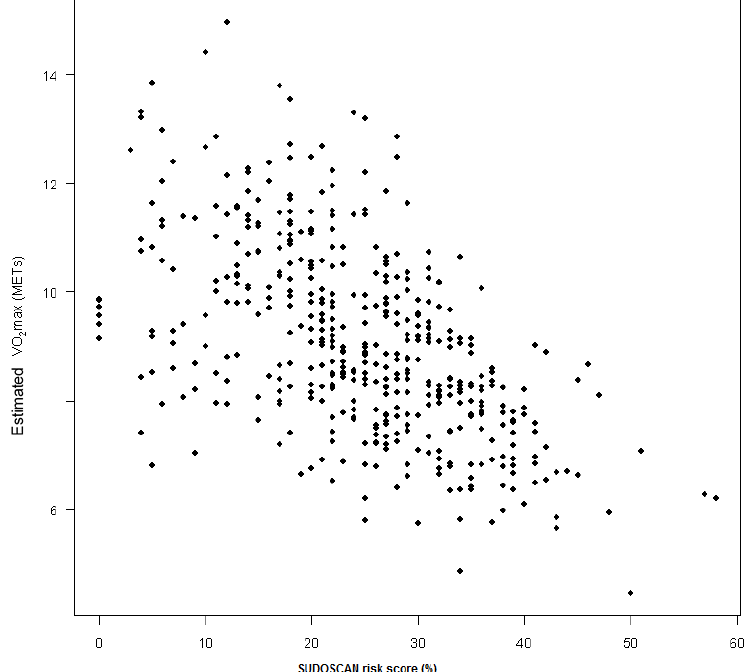
Figure 2. Correlation between SUDOSCAN risk score based on sudomotor dysfunction and estimated VO max in women ( n = 2